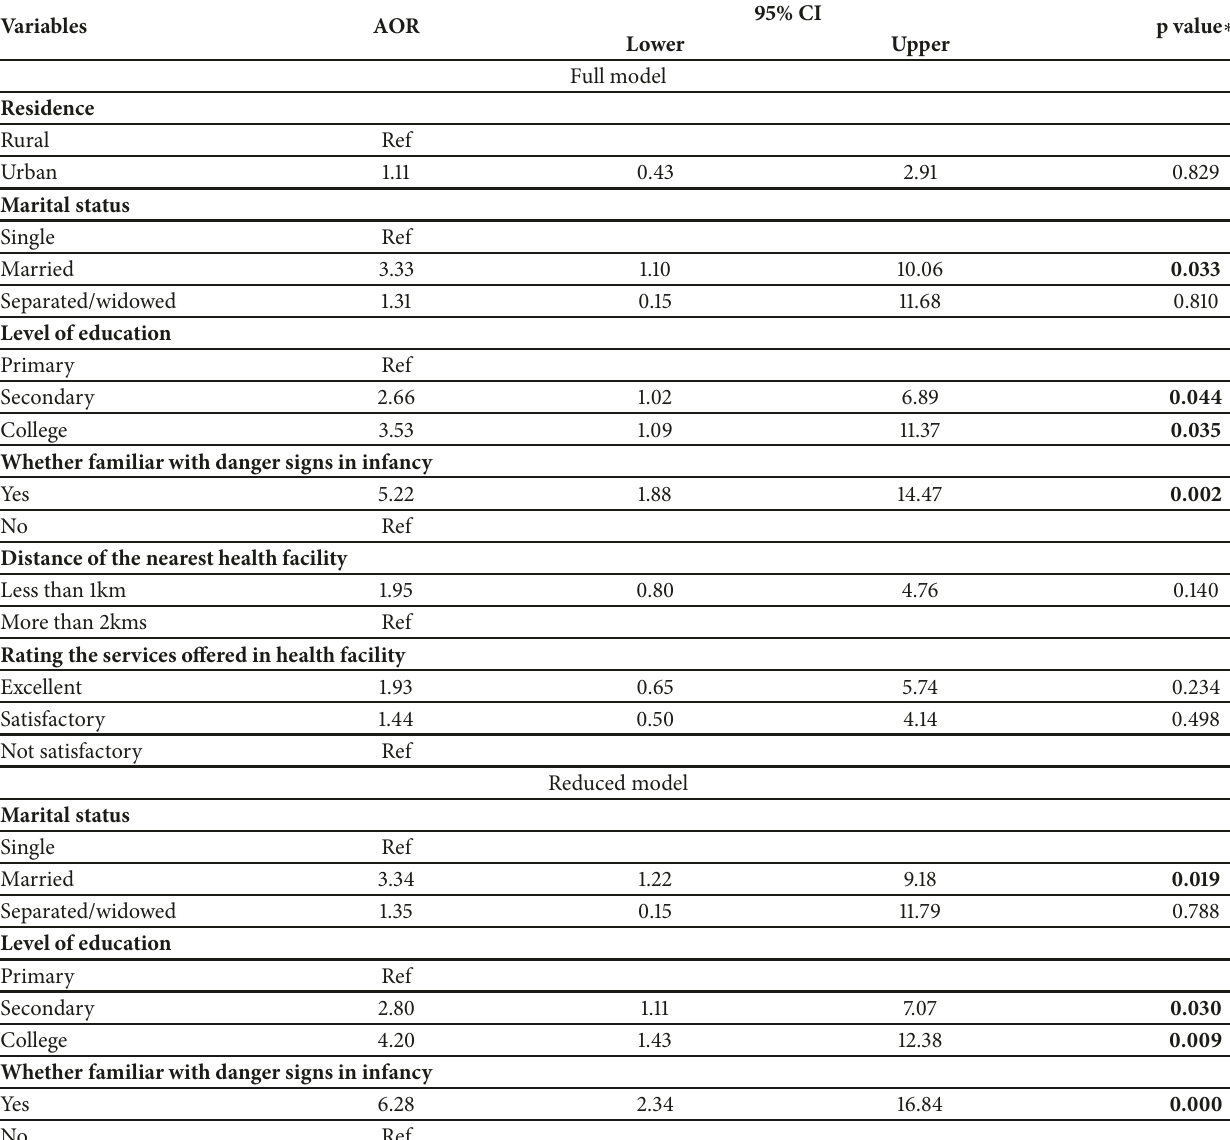
Table 6: Determinants of immediate health seeking for sick infants admitted with acute childhood